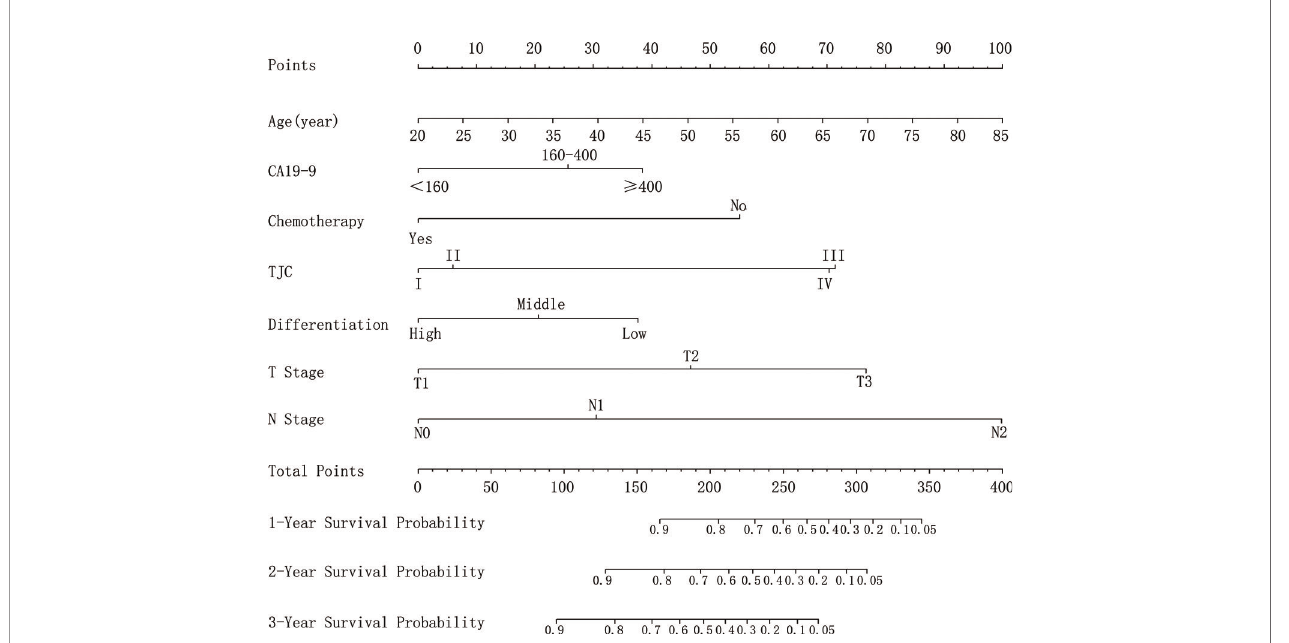
FIGURE 2 | The developed nomogram for predicting overall survival. The nomogram was developed based on the training cohort, with the use of age, preoperative CA19-9 levels, adjuvant chemotherapy, Tongji classi fi cation, differentiation degree, T stage, and N stage. CA 19-9, cancer antigen